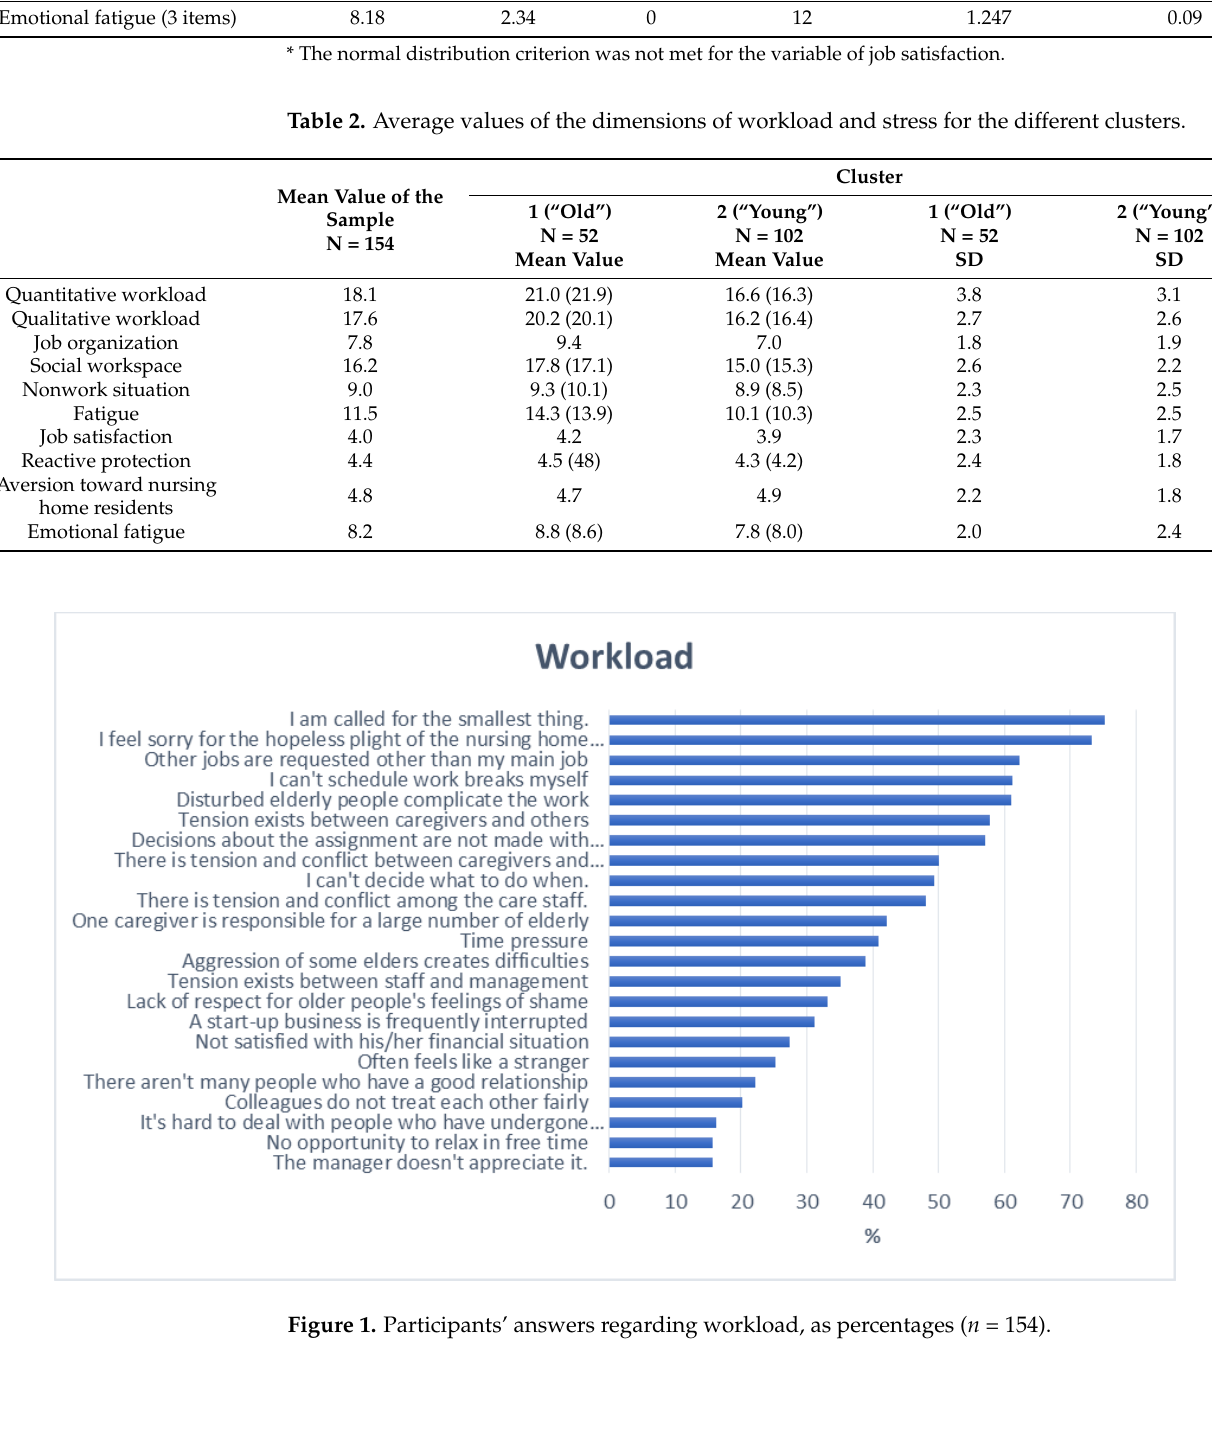
Figure 2. Participants’ answers about work stress, as percentages ( n = 154). 4. Discussion This study provided an overview of an assessment of the workload and stress levels of nursing home staff working with the 14-day continuous shift system, which was im- plemented for the first time ever in nursing homes in Turkey during the pandemic period. The aim of this study was to investigate the workload and work stress levels experienced